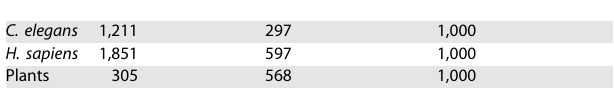
Table 1. The Numbers of Training Sequences for Building